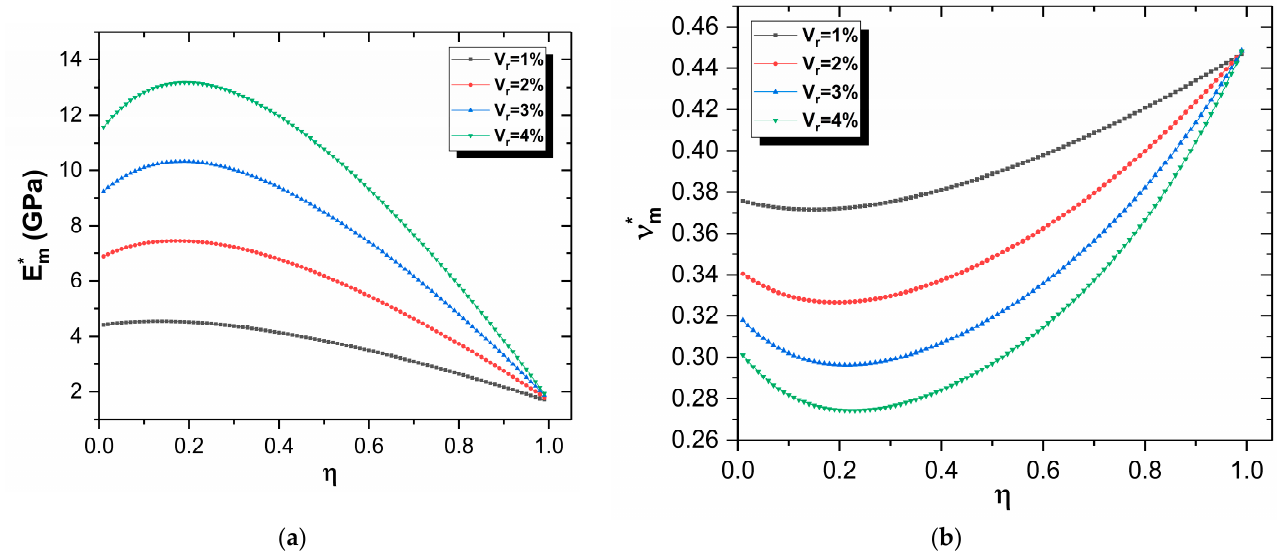
Figure 14. Effective elastic moduli of composite reinforced by random CNT inclusion in PP matrix, in function of η for 𝜇 = 0.2 with a maximum of Young’s modulus 𝐸 (cid:3040)∗ and minimum of Poisson’s